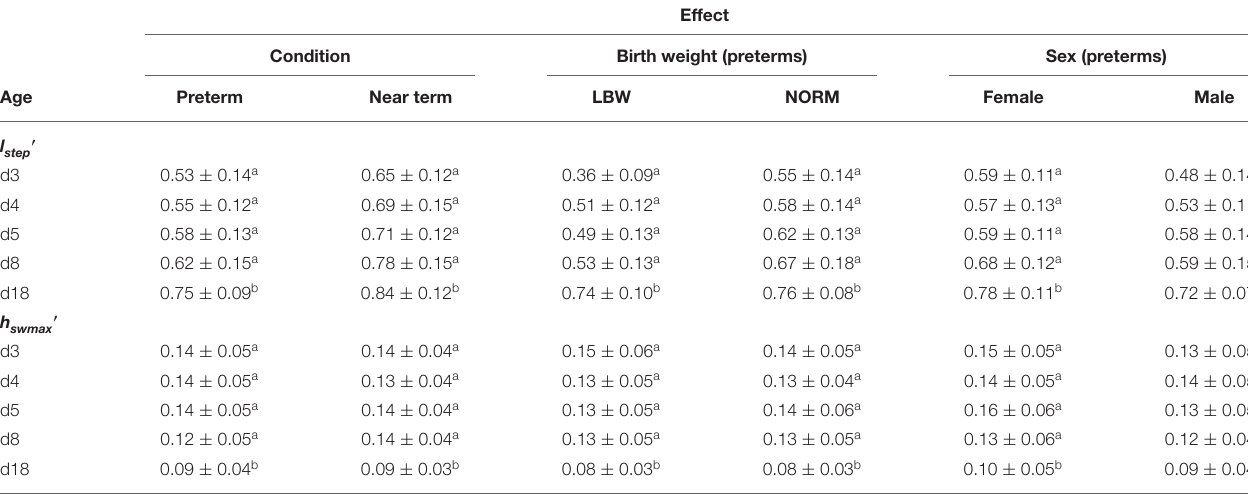
TABLE 5 | ormalized step length ( l step ′ ) and maximal swing height ( h swmax ′ ) (mean gestational age 106 days—term at gestation age 115 days) and postnatal age (3, 4, 5, 8, and 18 days), birth weight (low birth weight (LBW): 0–25th percentile—normal birth weight (NORM): 50–75th percentile), and sex (female vs.